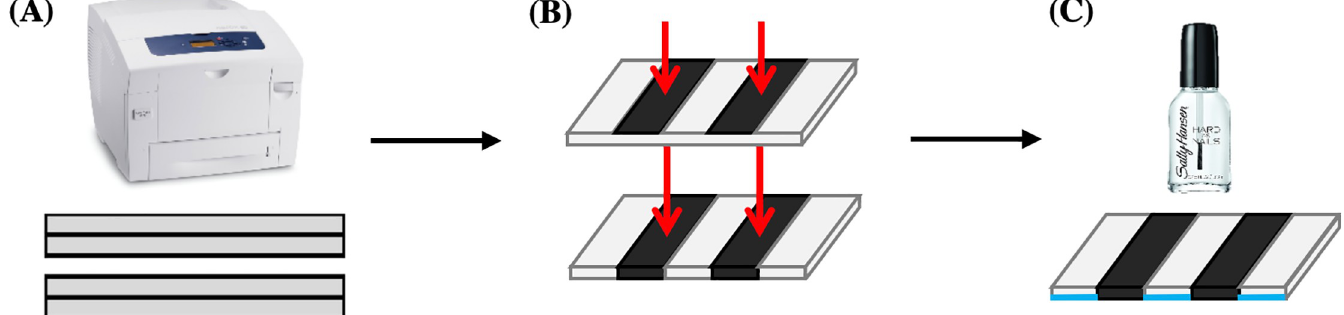
Fig 1. μ PAD paper preparation. The schematic represents the preparation of the μ PAD. (A) We printed the channels with the Xerox ColorQube 8580. We printed the channels with a width of .4 cm, length of 10.1 cm, and barrier thickness of 3 mm. These dimension account for the wax diffusion that occurs during the melting phase. (B) We melted the channels in an oven set to 100˚C. (C) Then, we brushed clear nail polish, denoted by the blue regions, in the unprinted, hydrophilic channels on one side of the paper.